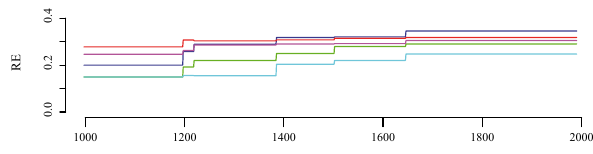
Fig. 8. Evolution of RE statistics for the nested reconstructions in Figure 8 . Evolution of RE statistics for the nested reconstructions in each region of SSA. RE values were updated each time a new low frequency proxy was added to the reconstruction. each region of SSA. RE values were updated each time a new low Colors are the same as in Figure 3. frequency proxy was added to the reconstruction. Colors are the same as in Fig.